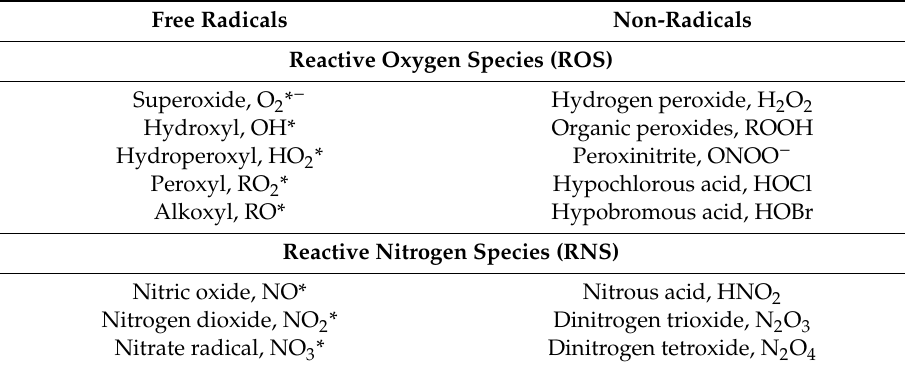
Table 1. Biologically important reactive oxygen and nitrogen species (Adapted from Halliwell and Gutteridge